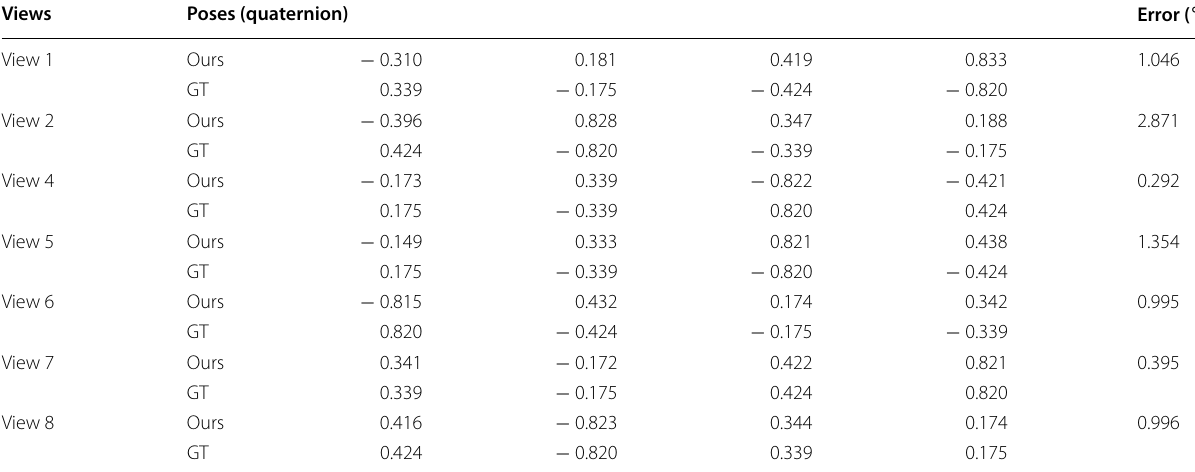
Table 2 Pose prediction results of the 7 fixed views